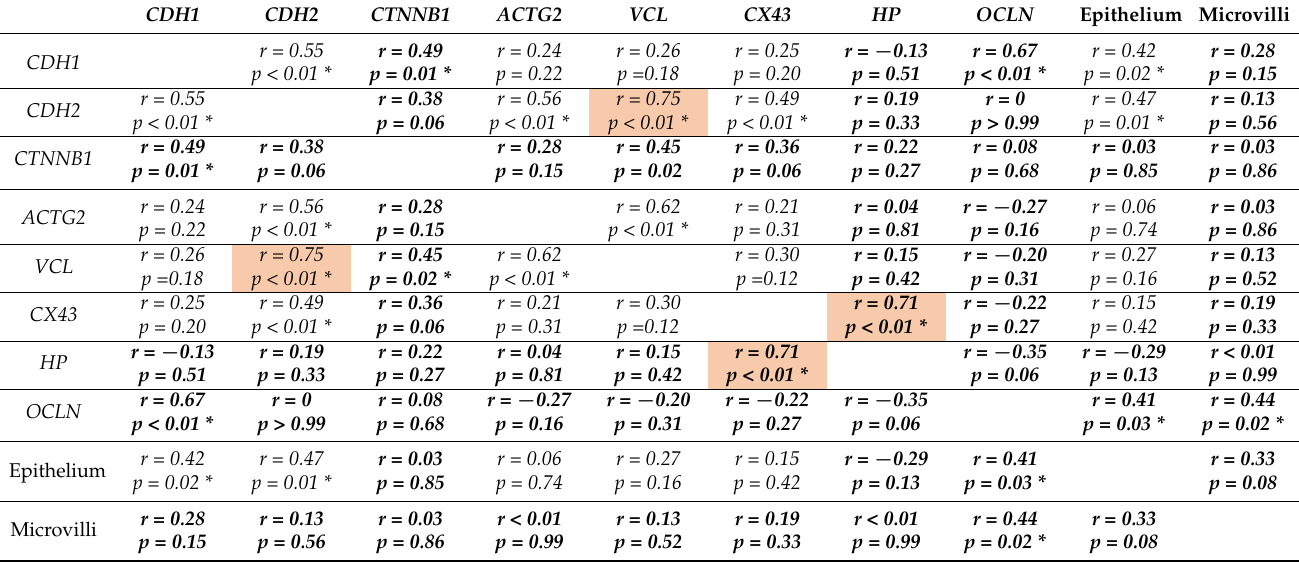
Table 2. Results of a simple correlation between CDH1 , CDH2 , CTNNB1 , CX43 , VCL , OCLN , HP , ACTG2 , the epithelium, and microvilli in the large intestine.